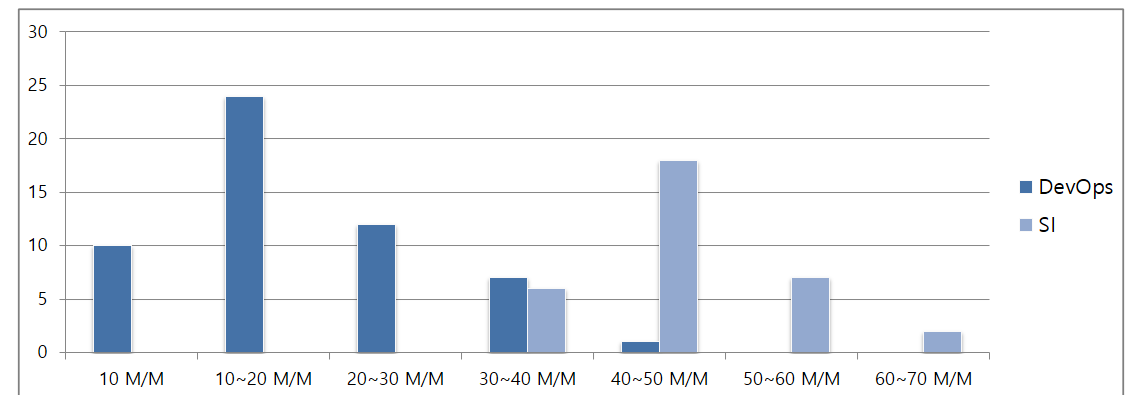
Figure 13. Costs by project. Processes 2018 , xx, x FOR PEER REVIEW Table 6. Workforce input by year, project type.